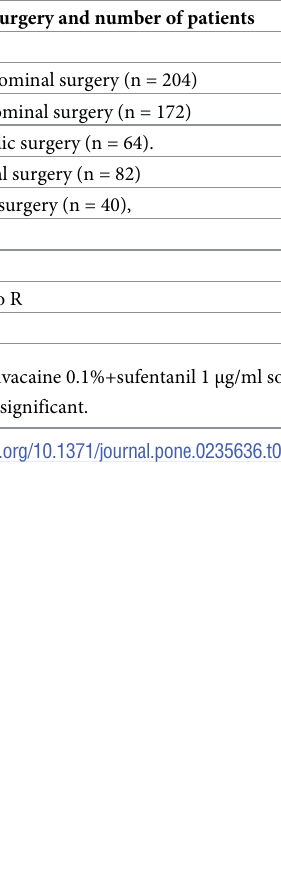
Orthopedic surgery (n = 64).